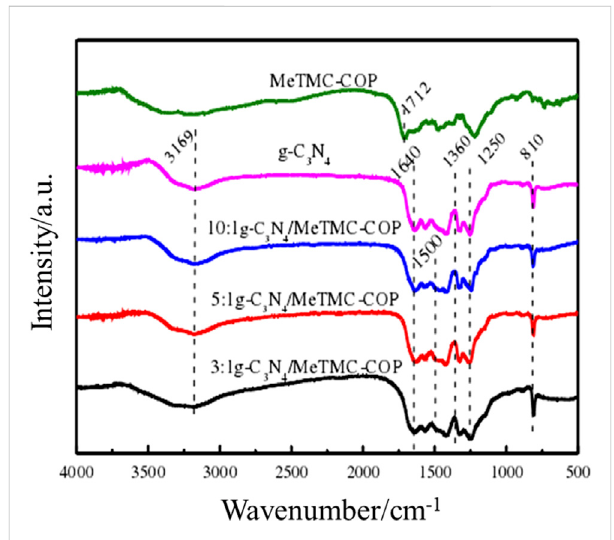
FIGURE 2 FT-IR spectra of different ratios of g-C 3 N 4 /Me